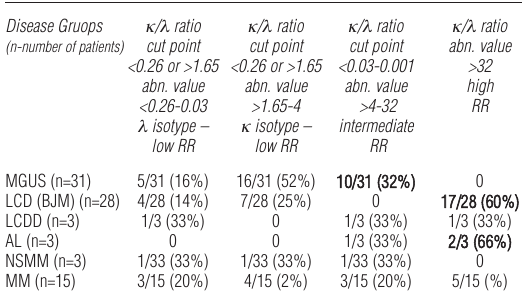
Table. Percentage of FLC ratio in plasmaproliferative diseases groups. From 2004 to 2010 yrs. Disease